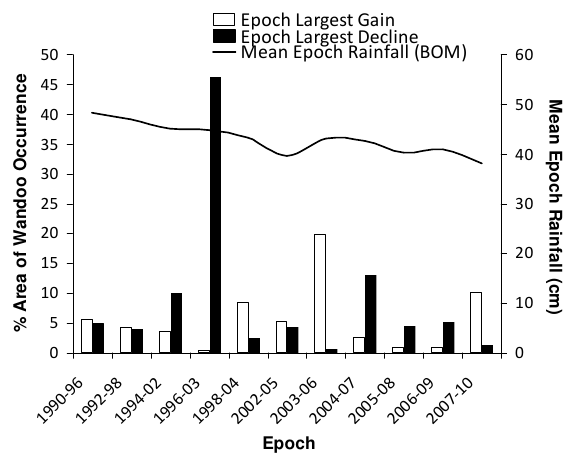
Figure 3. Bar graph showing percentage of wandoo occurrence area for each four date epoch with the largest declining and gaining trend in cover. Line graph shows mean epoch rainfall across wandoo occurrence from interpolated rainfall data (Bureau of Meterology